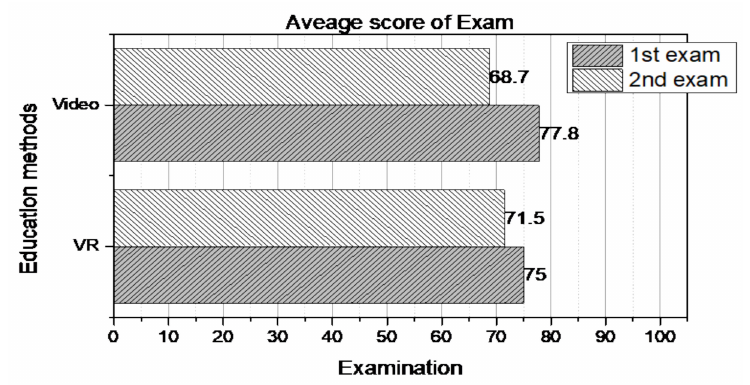
Figure 8. 1st and 2nd results of examinations for Group 1 and Group